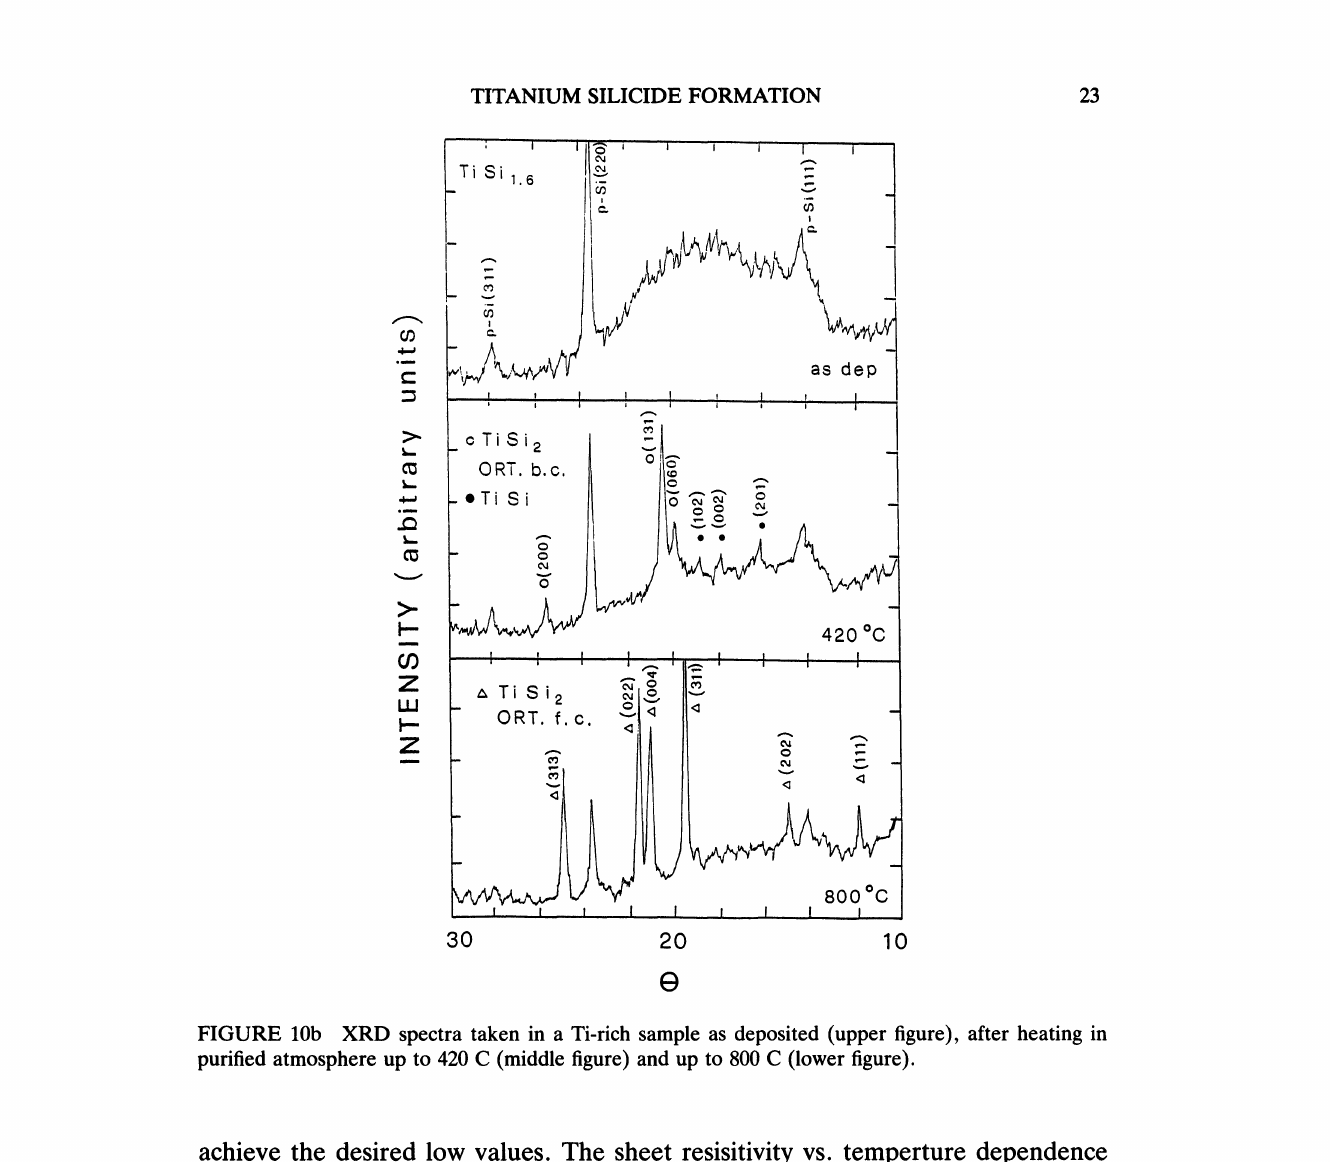
FIGURE 10b XRD spectra taken in a Ti-rich sample as deposited (upper figure), after heating in purified atmosphere up to 420 C (middle figure) and up to 800 C (lower